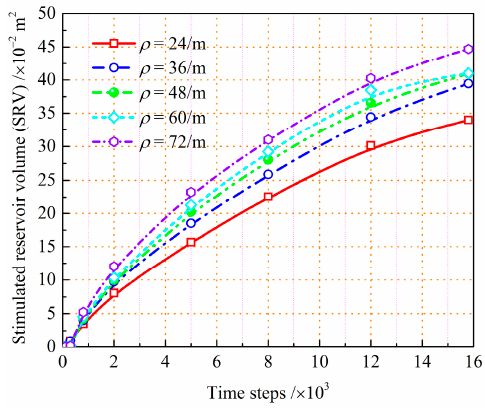
Figure 17. Change of stimulated reservoir volume (SRV) with time steps when natural fracture (NF) density ranges from 24 to 72/m when injection rate is 2.0 × 10 − 6 m 3 /s and S H : S h = 10:5. Figure 18 demonstrates the evolution of injection pressure under different NF densities. Within